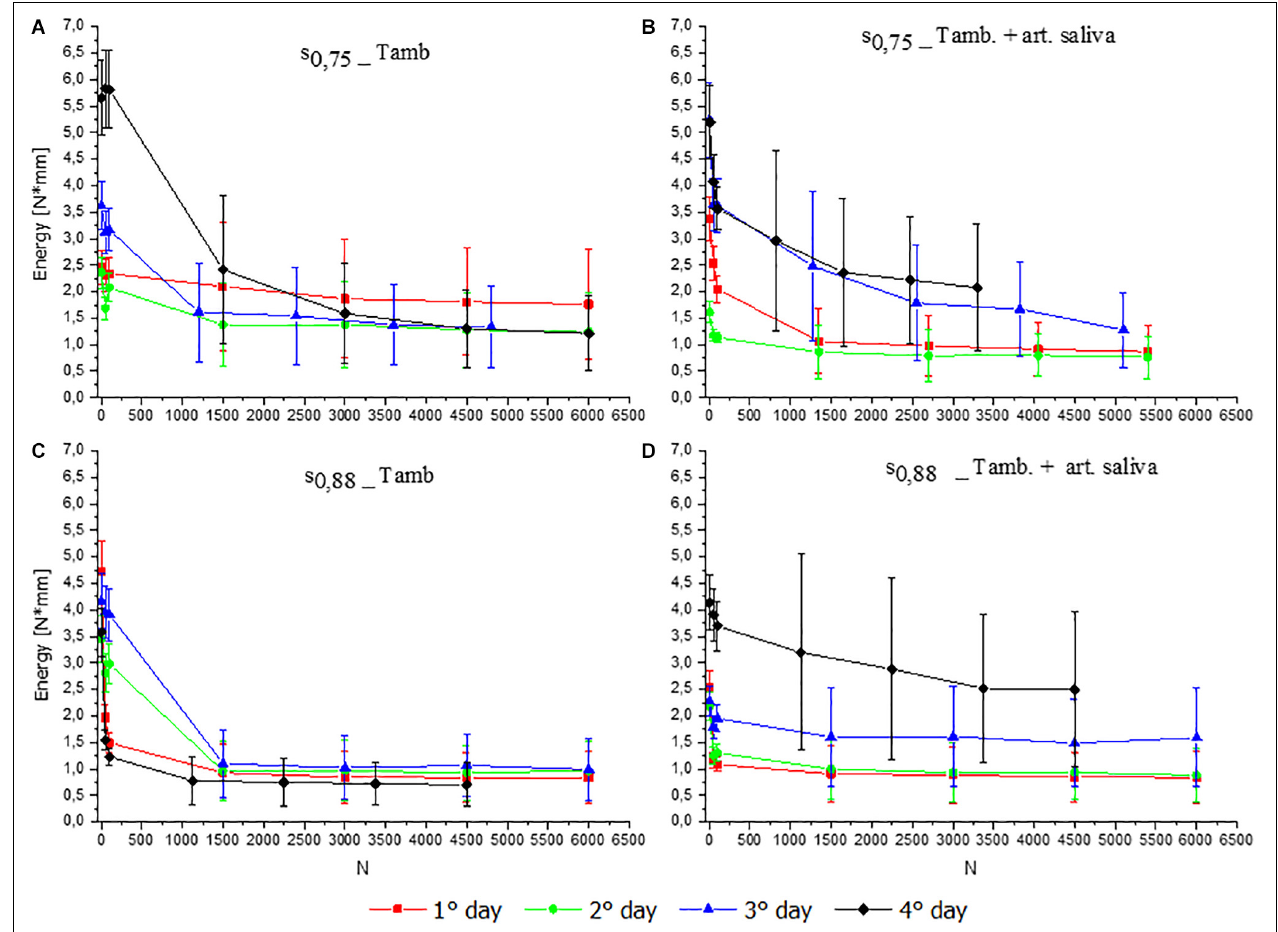
FIGURE 6 | Variation of hysteresis loop energy vs. number of cycles for the two copolymers thicknesses. 0.75 mm sample tested (A) in atmospheric environment ( ∼ 25 ◦ C) and (B) in presence of artificial saliva and at room temperature. 0.88 sample mm tested (C) in atmospheric environment ( ∼ 25 ◦ C) and (D) 0.88 mm sample tested in presence of artificial saliva and at room